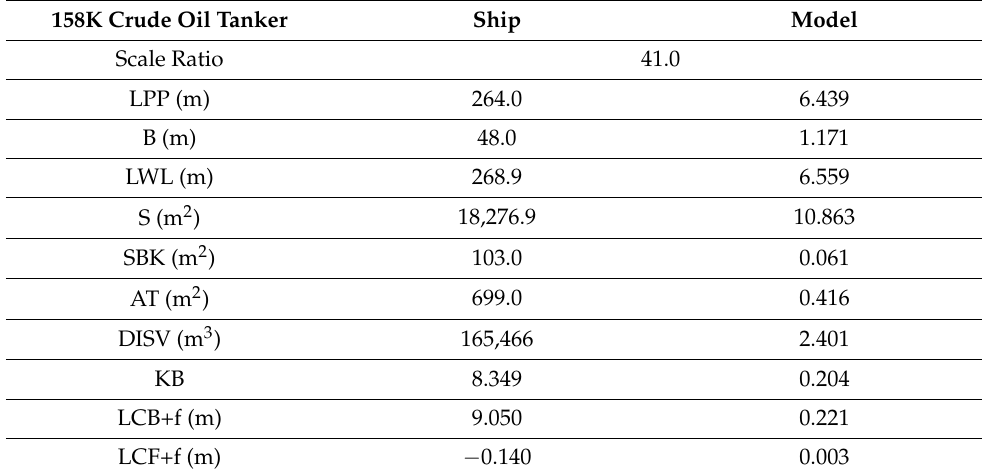
Table 11. Main dimension of target ship for scale ratio 41.0.